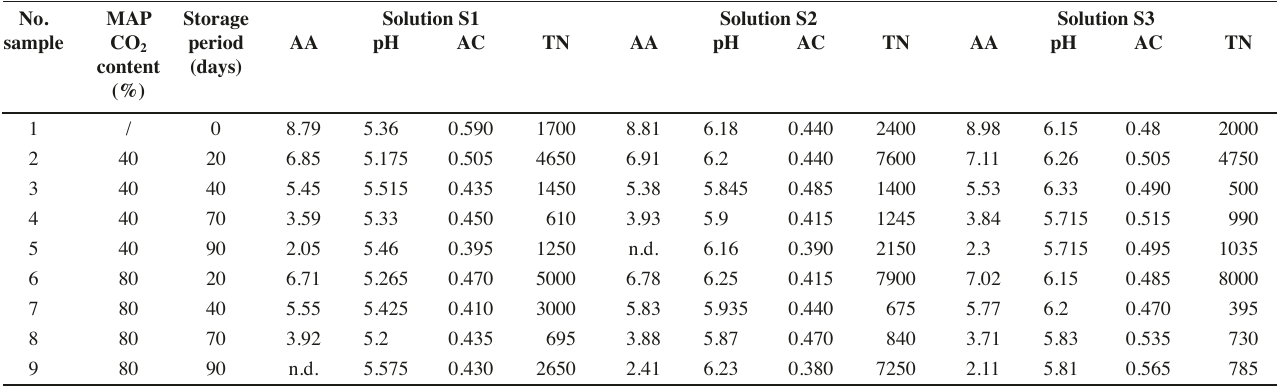
Tab. 1: Experimental data for the shelf-life study of OT cabbage packaged in different MAP